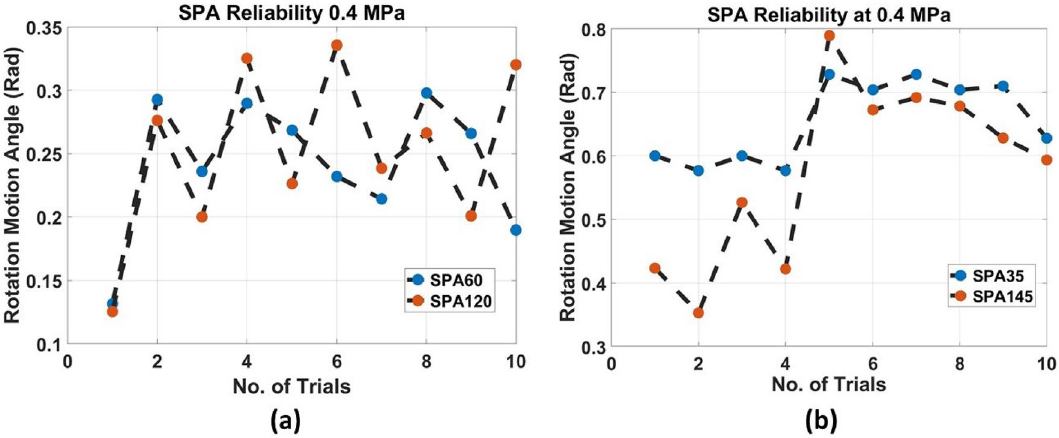
Figure 7. Reliability performance for SPAs against different trials at applied pressure of 0.4 MPa, ( a ) reliability performance for SP60 and SPA120, ( b ) reliability performance for SPA35 and SPA145.